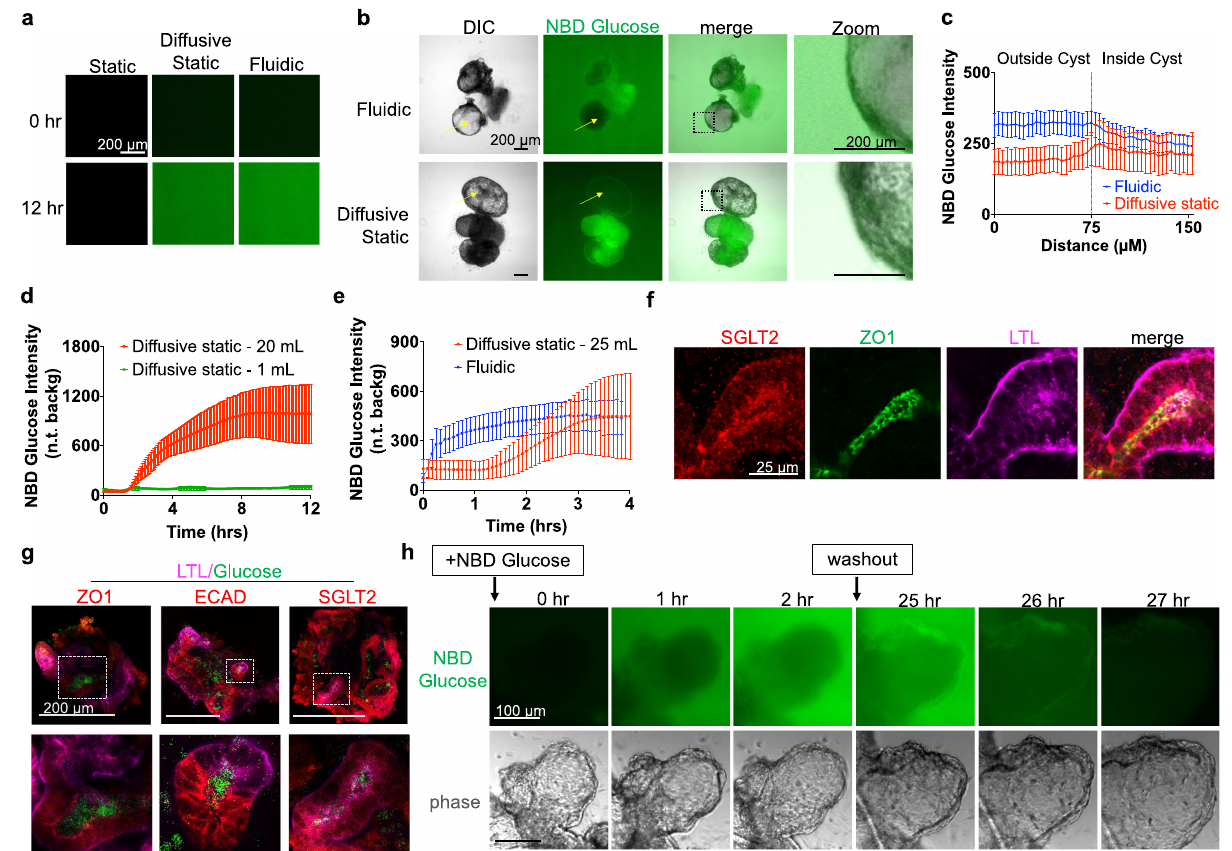
Fig. 3 | PKD organoids absorb glucose under fl uidic and static conditions. timepointbymeasuringthe fl uorescenceintensityofasquareregionplacedinthe